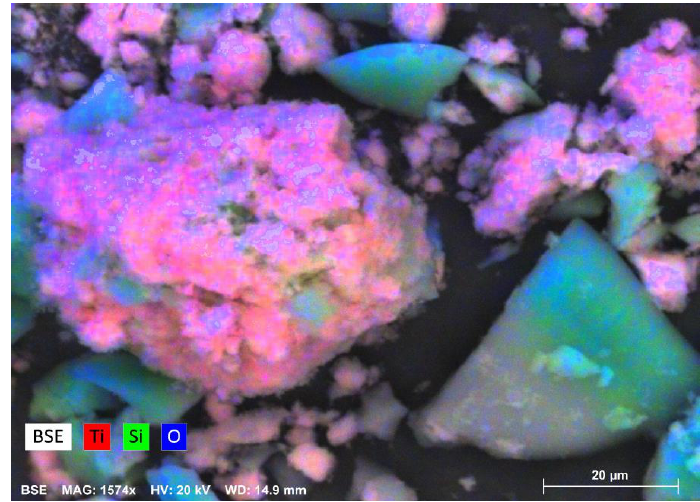
Figure 7. SEM backscatter image with XPS elemental mapping. Silica grains are shown in green hues, while titanium is shown in red. The silica grain shown in the beam focus is thoroughly coated on all faces and edges, indicating homogenous bonding.